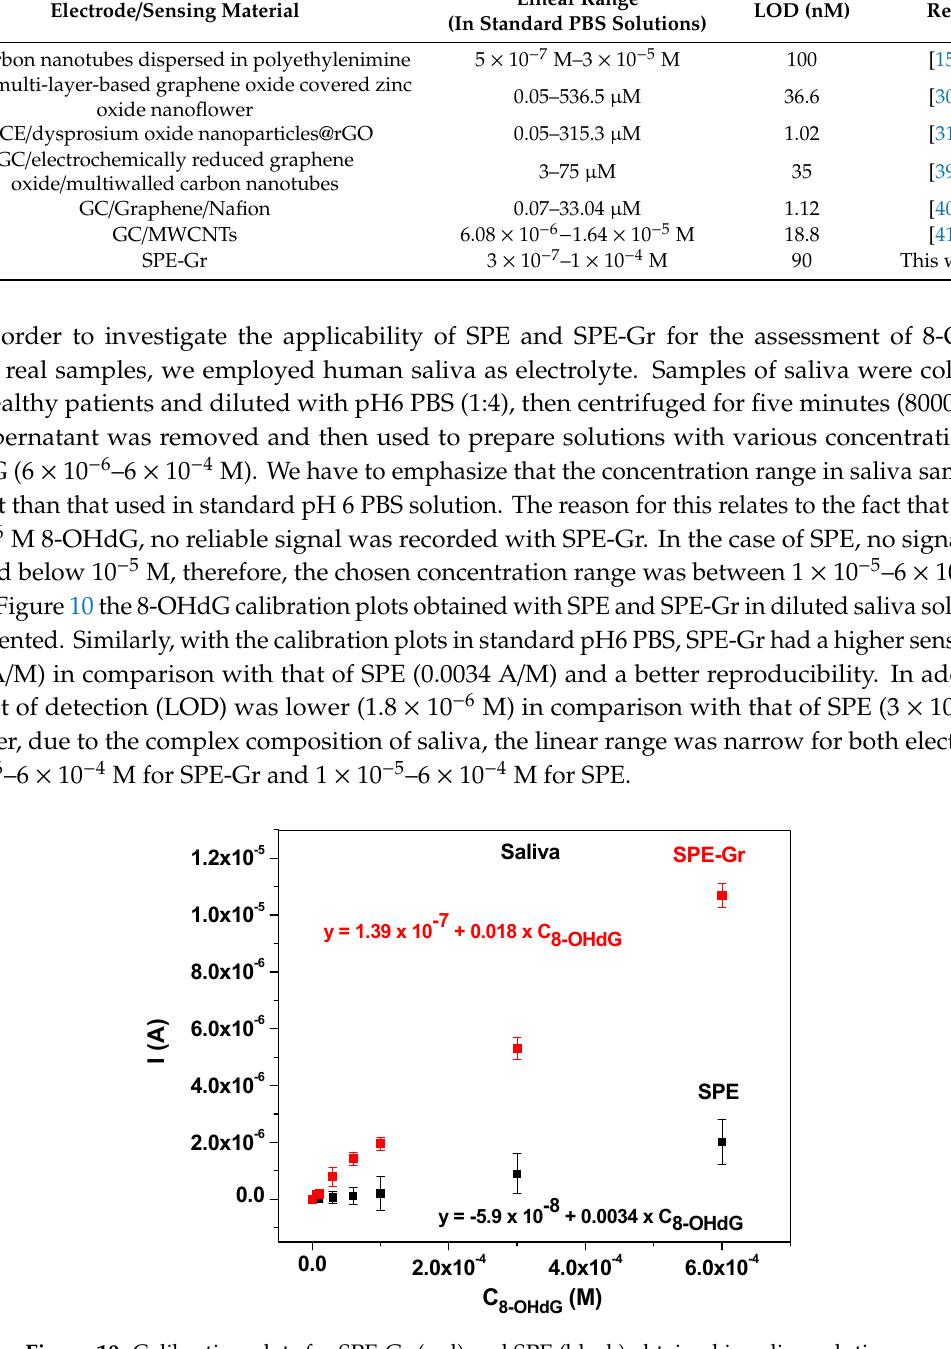
Figure 10. Calibration plots for SPE-Gr (red) and SPE (black) obtained in saliva solutions.